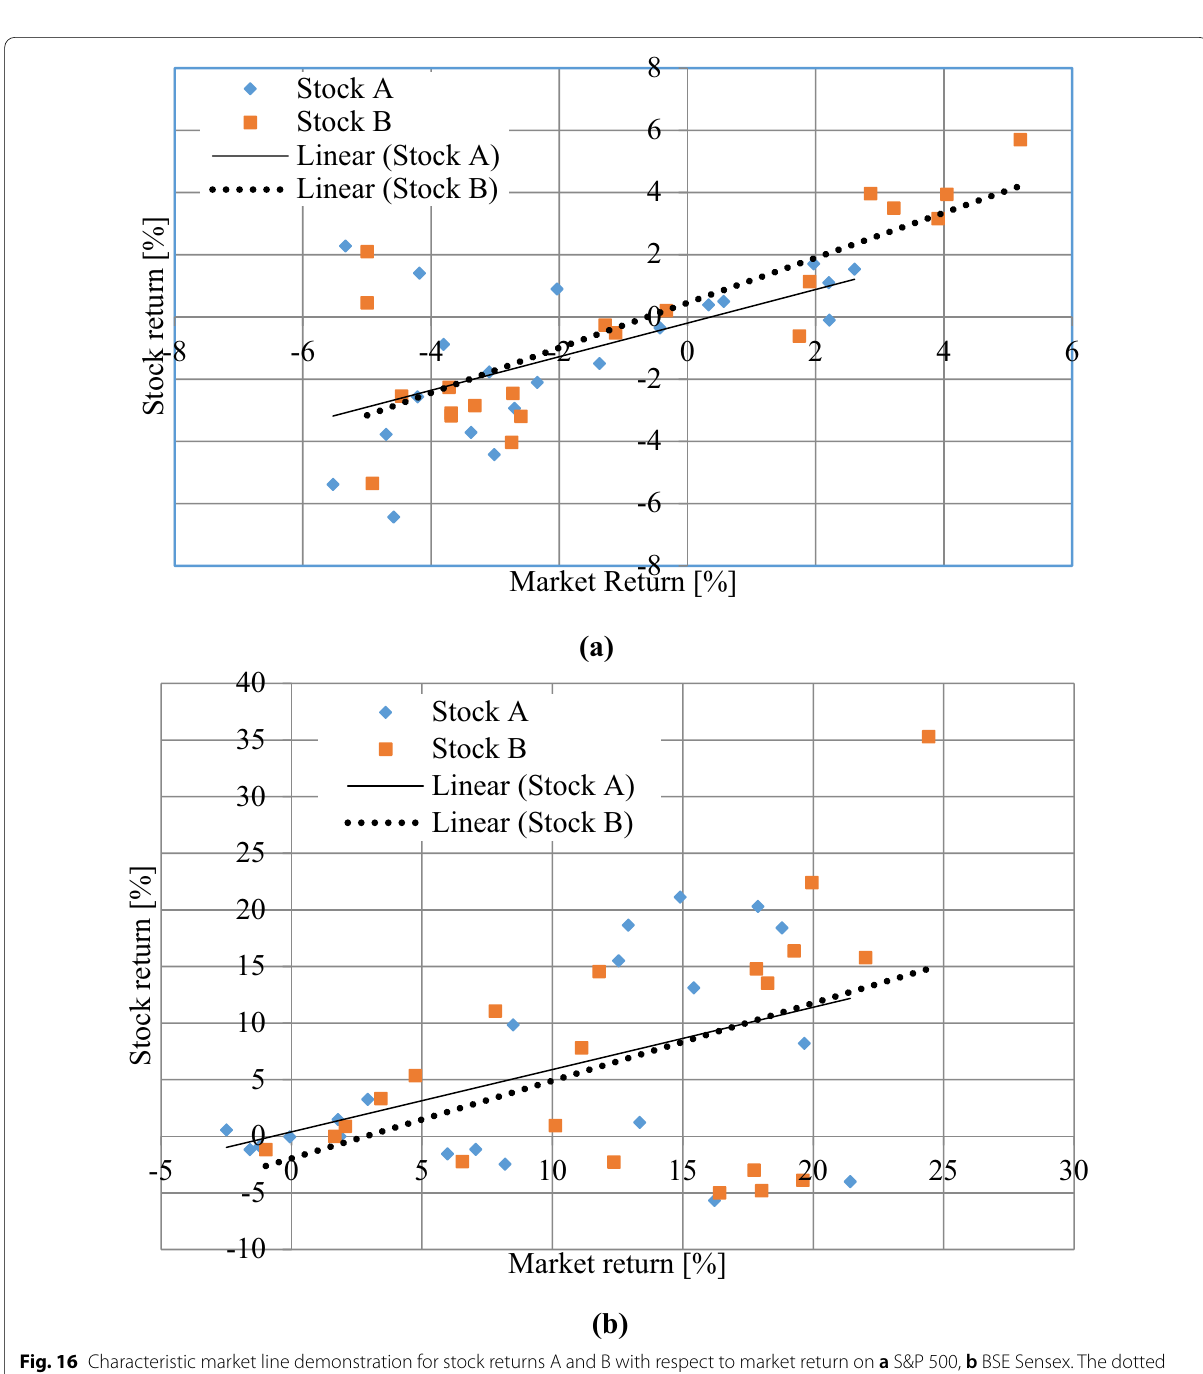
Fig. 16 Characteristic market line demonstration for stock returns A and B with respect to market return on a S&P 500, b BSE Sensex. The dotted line and black lines show the linear fit for stock